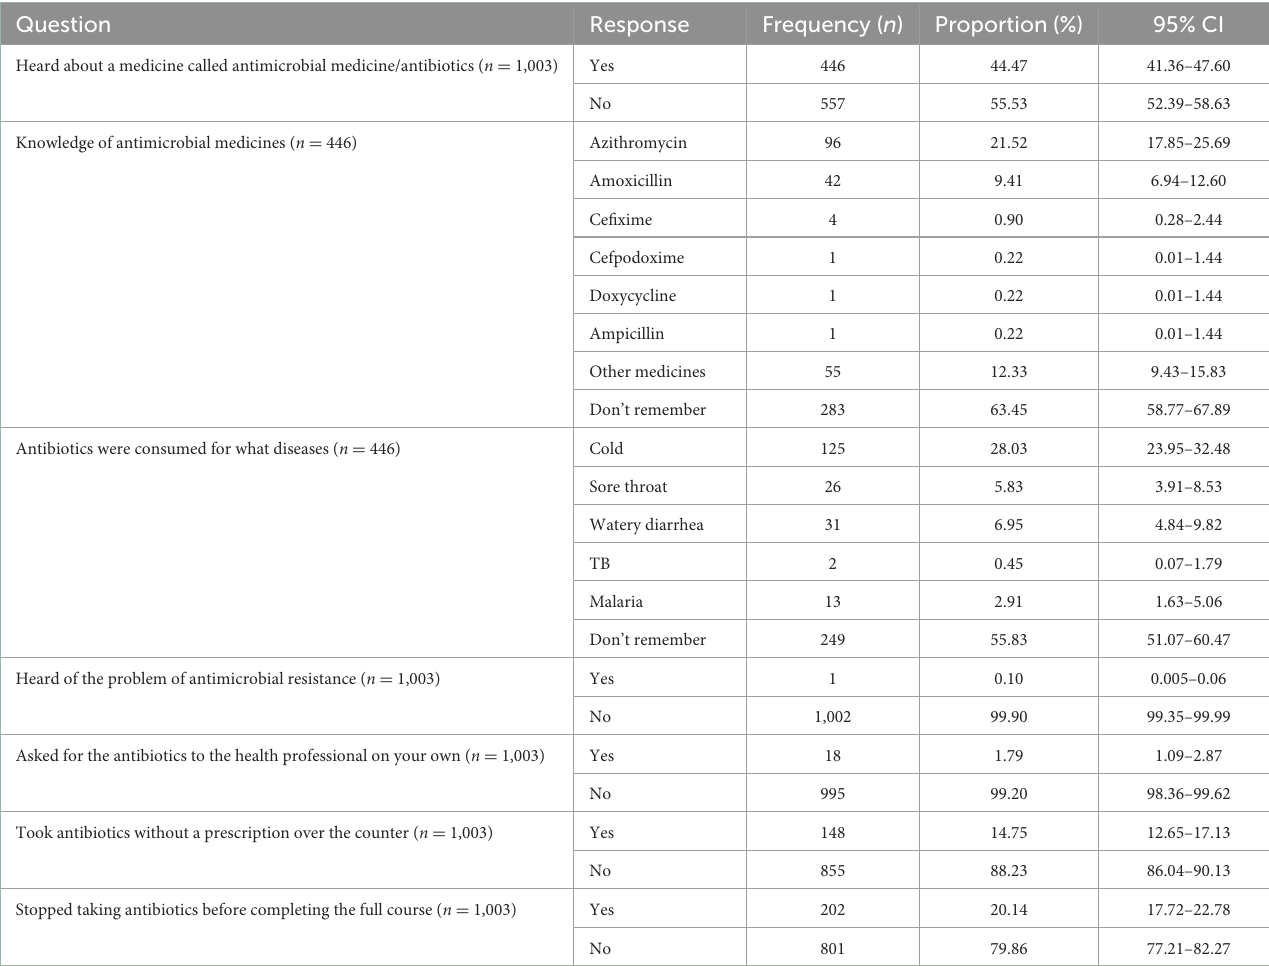
TABLE 2 KAP on antimicrobial usage and